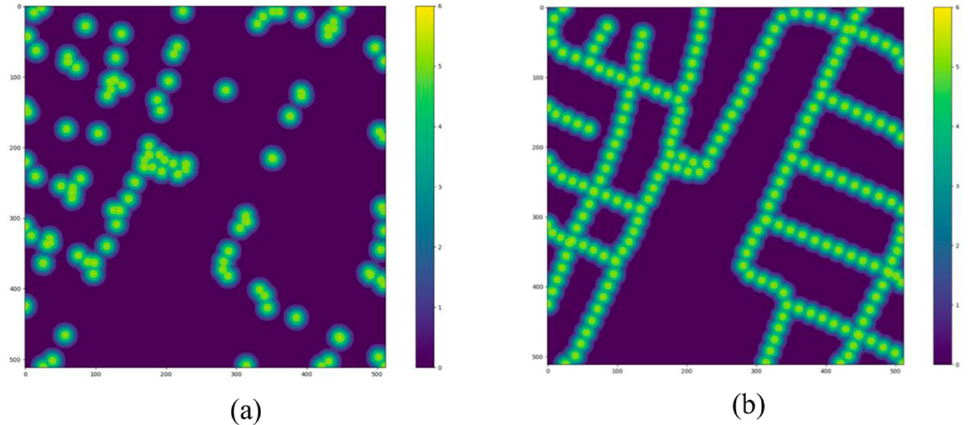
Figure 5. Visualization of the node heatmap: ( a ) represents inflection point in road heatmap; ( b ) represents the encrypted heatmap.